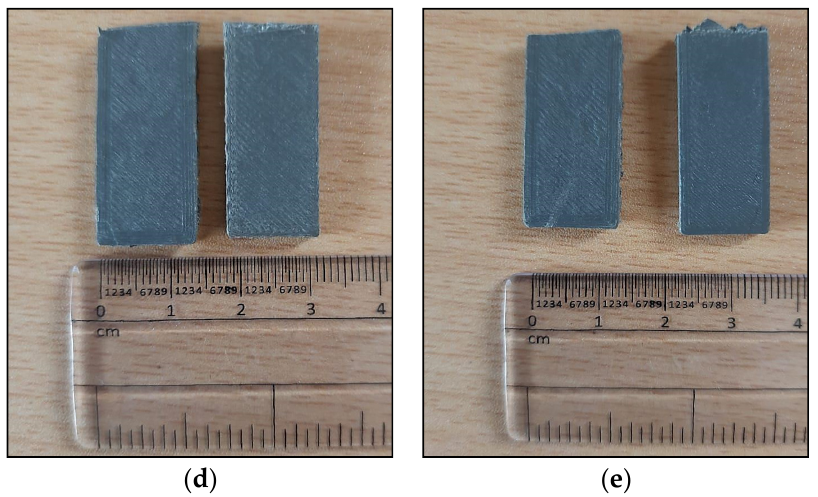
Figure 19. Photographs of fractured specimens after impact test: ( a ) PC-ABS; ( b ) PC-ABS+0.2 wt % graphene; ( c ) PC-ABS+0.4 wt % graphene; ( d ) PC-ABS+0.6 wt % graphene; ( e ) PC-ABS+0.8 wt % graphene.